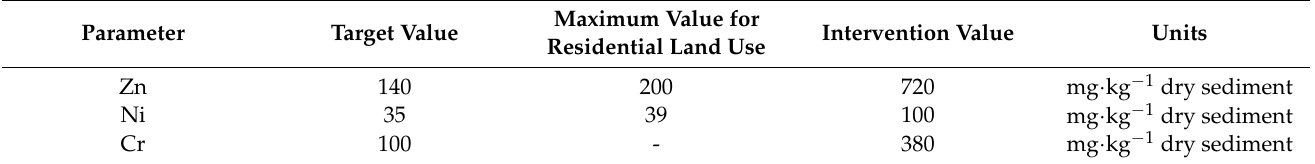
Table 3. Target values for soil with 10% organic matter and 25% clay.